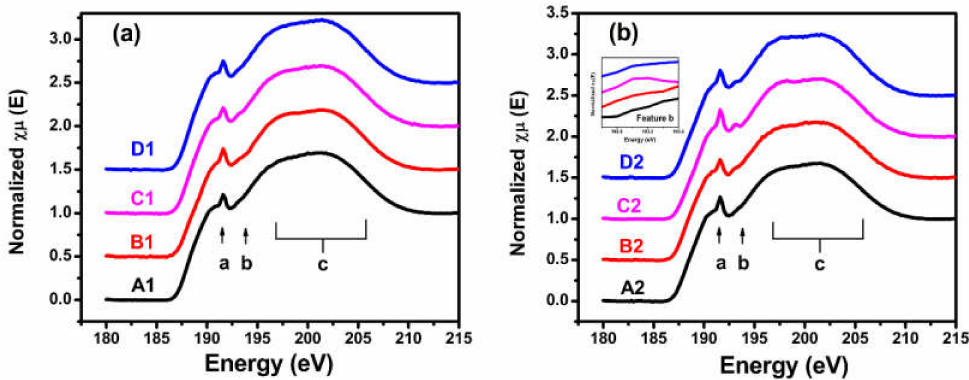
Figure 1. The B K-edge X-ray absorption near-edge structure (XANES) spectra of the B 4 C films ( a ) and B 4 C/Pd layers ( b ) in the different storage environments. Samples A1 and A2 were placed in a dry nitrogen environment; samples B1 and B2 were placed in the atmosphere; samples C1 and C2 were placed in a dry oxygen-rich environment; and samples D1 and D2 were placed in a wet nitrogen environment. The insert in Figure 1b is an enlarged view of feature b in the B 4 C/Pd